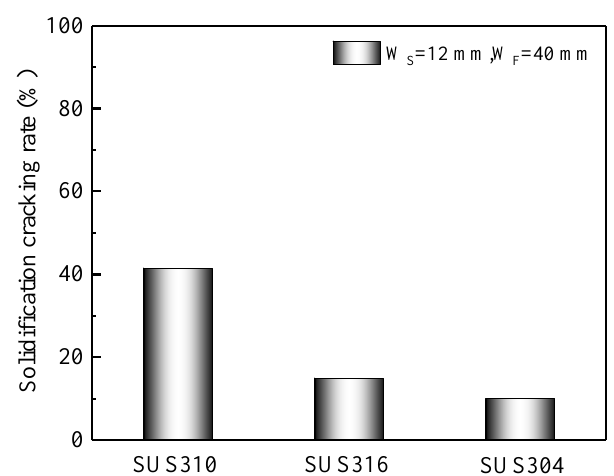
Figure 9. E ff ect of the chemical components on the solidification cracking rate during laser welding at the welding speed of 1.0 m / min.